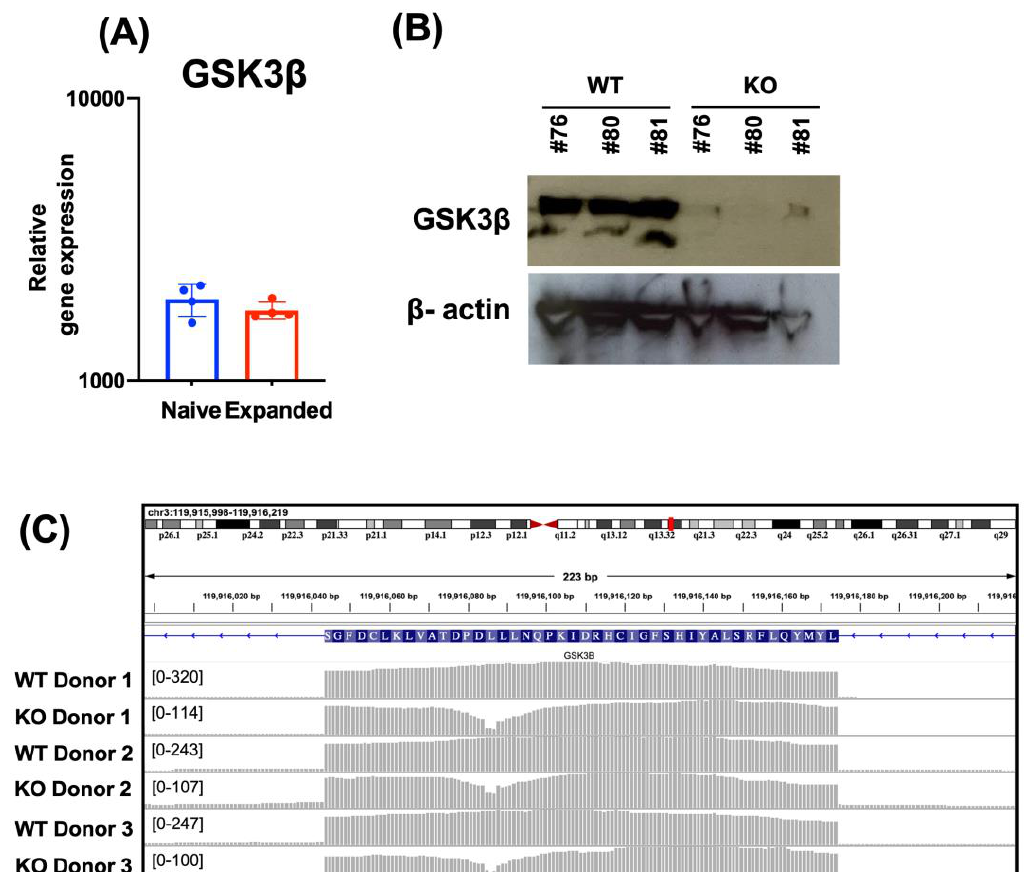
Figure 1. Generation of GSK3B -KO FC-21 expanded NK cells. GSK3B expression in NK cells